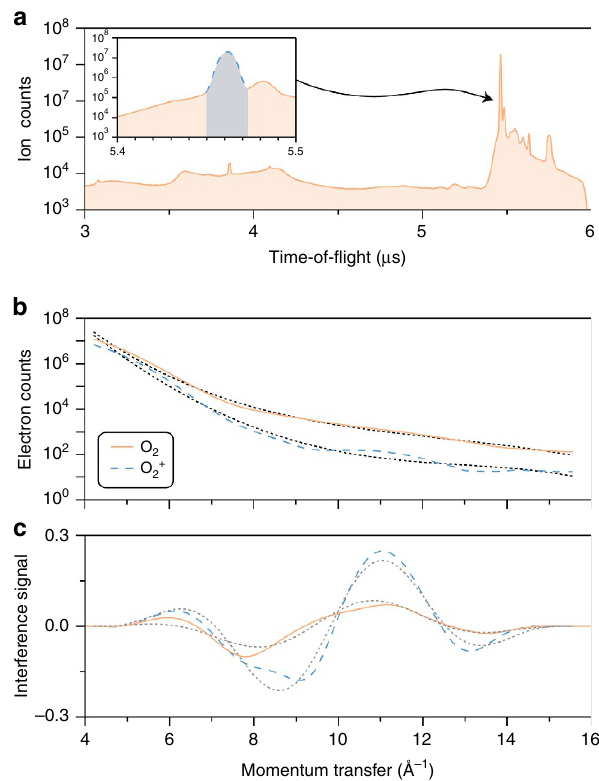
Figure 3 | Importance of correctly sampling the momentum transfer space. ( a ) The ionic time-of-flight measured after the ionization of O 2 . The inset shows the small temporal range over which the O 2 þ ions are detected (blue shading). Other ions that are not of interest in this manuscript are also detected (orange shading). ( b ) The extracted backscattered electron distributions when electrons coincident with all ions (orange, solid) or only O 2 þ (blue, dashed) are utilized. Fourth-order polynomial fits are also presented (black, dotted). ( c ) The corresponding interference signals for O 2 þ (blue, dashed) and all (orange, solid) electrons. Single sinusoidal fits (grey, dotted) to the data show that the observable modulation has decreased by a factor of